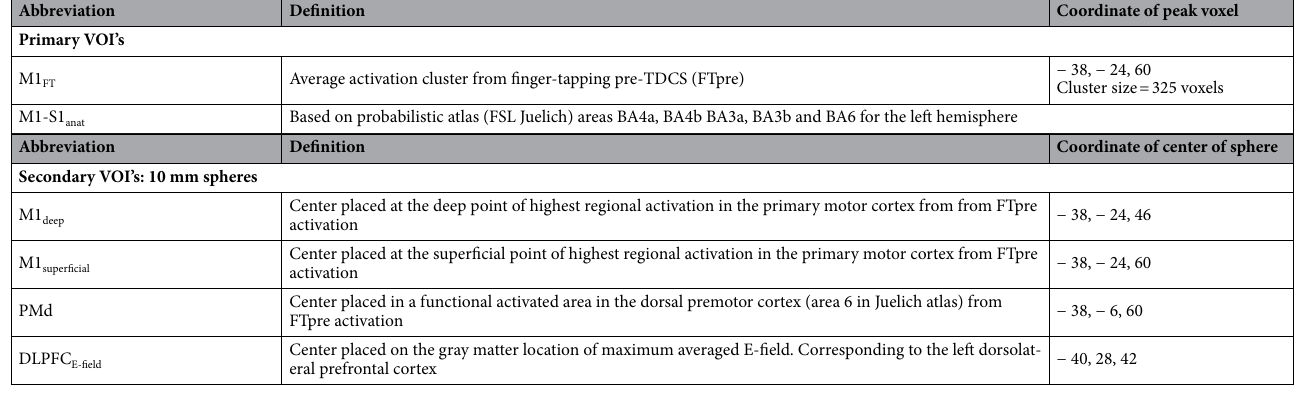
Table 3. Overview of